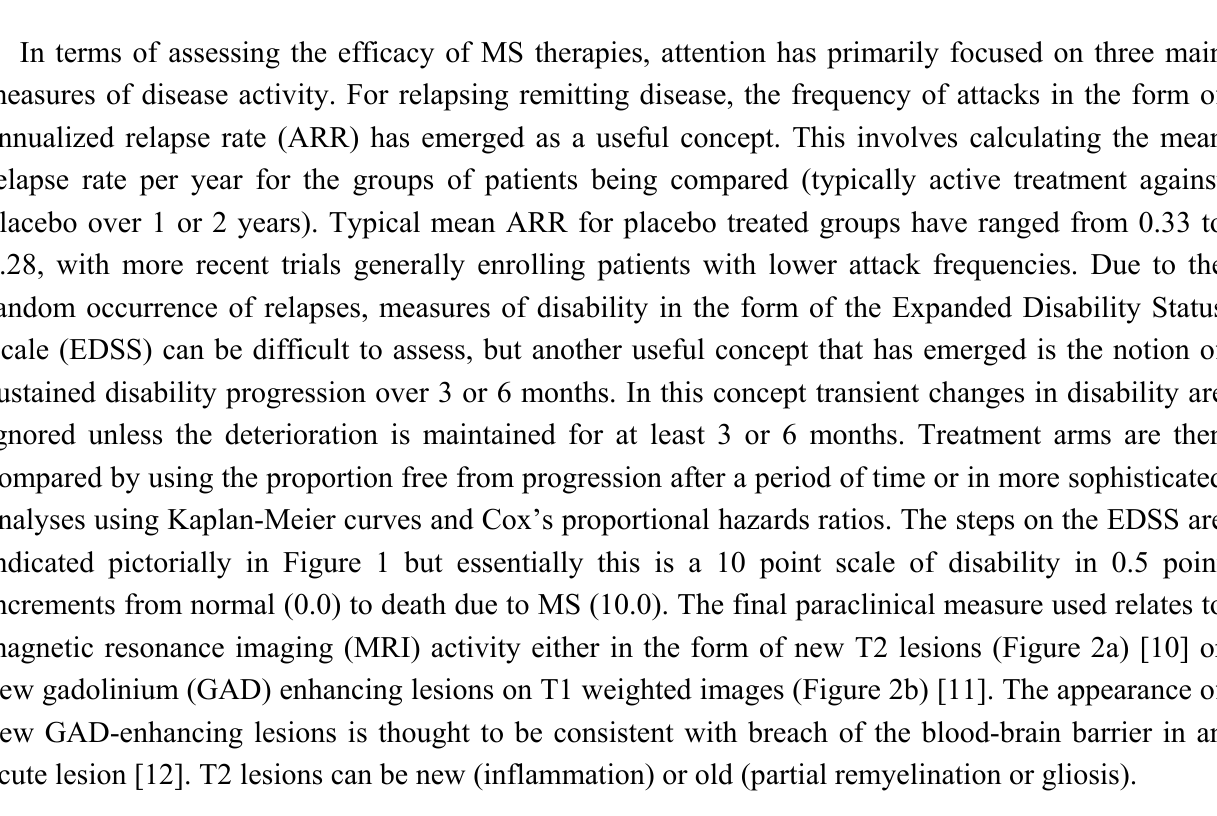
Figure 1. Schematic representation of the expanded disability status scale